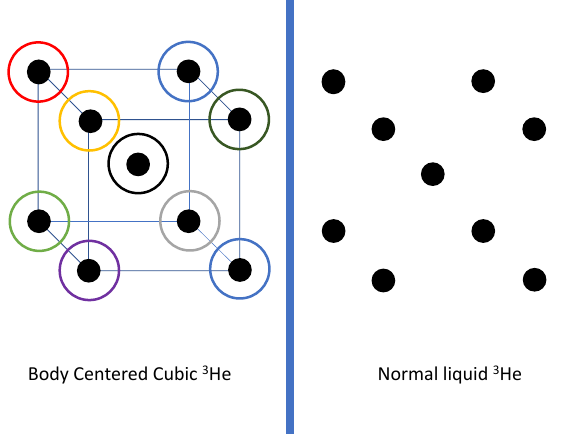
Figure 4: Discernibility and indiscernibility in 3 He : In liquid 3 He atoms are indis- tinguishable, but in solid 3 He, they are confined to specific sites in real space. This makes them distinguishable. In the solid near the melting transition, atoms wander around, thanks to their zero-point motion and can exchange their places with their neighbors. On the other hand, in the liquid, collisions in real space confine atoms to a restricted neighbourhood. The liquid solidifies when collisions confine each atom to a spatial